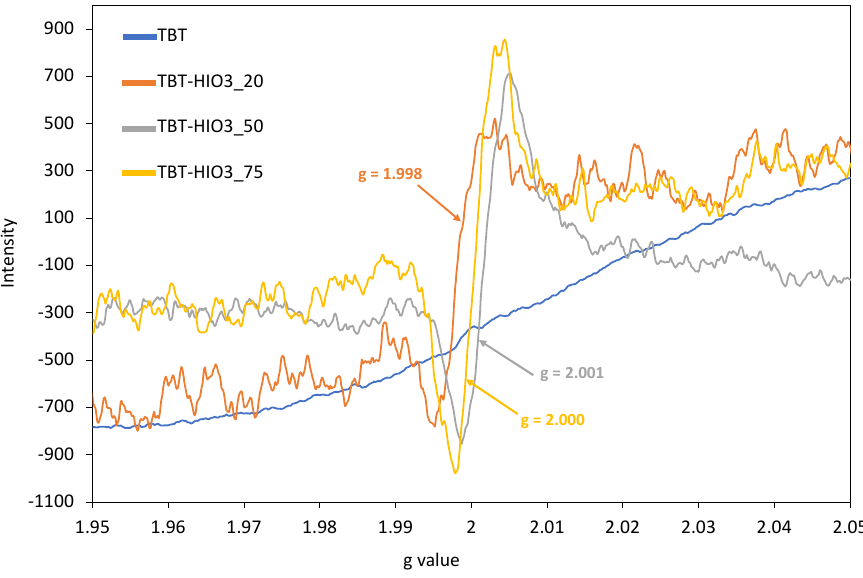
Figure 9. The EPR spectra recorded in the room temperature for selected defective TiO 2 -HIO 3 photocatalysts, compared with the pure TiO 2 –TBT sample (blue line).